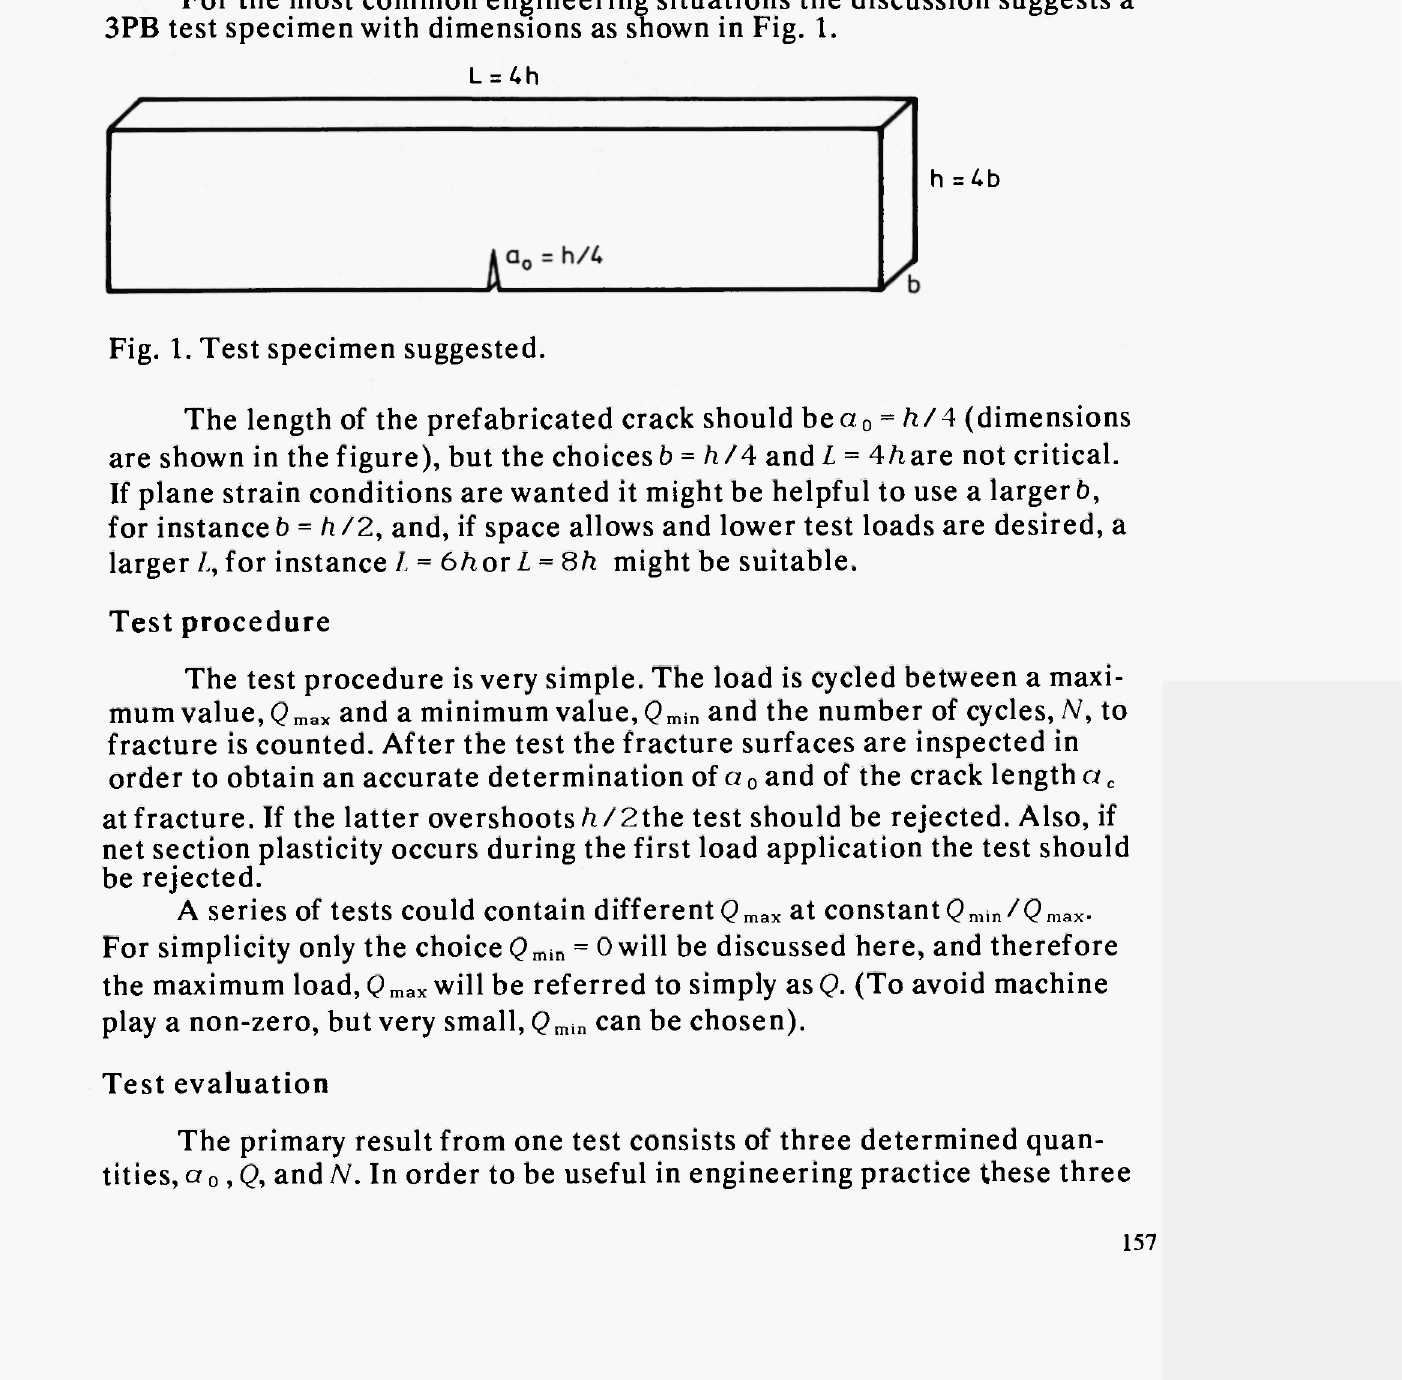
Fig. 1. Test specimen suggested. The length of the prefabricated crack should b e a